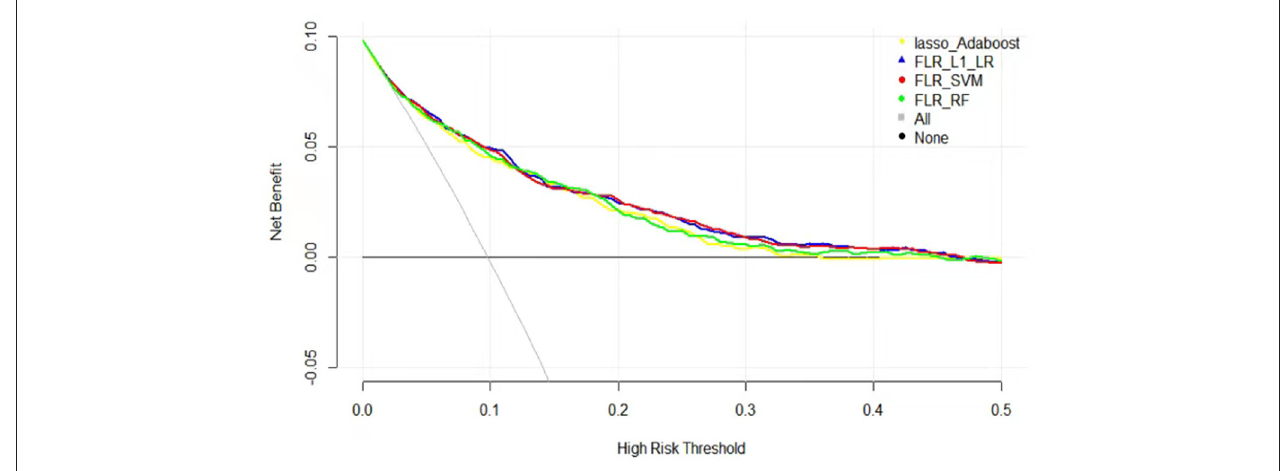
FIGURE 3 | Decision curves for predicting CVD outcomes in Xinjiang rural population using four ML models. CVD, cardiovascular disease; ML, machine learning; FLR-L1-LR, L1 regularized Logistic regression with forwarding Partial Likelihood Estimation; FLR-RF, Random forest with forwarding Partial Likelihood Estimation; FLR-SVM, Support vector machine with forwarding Partial Likelihood